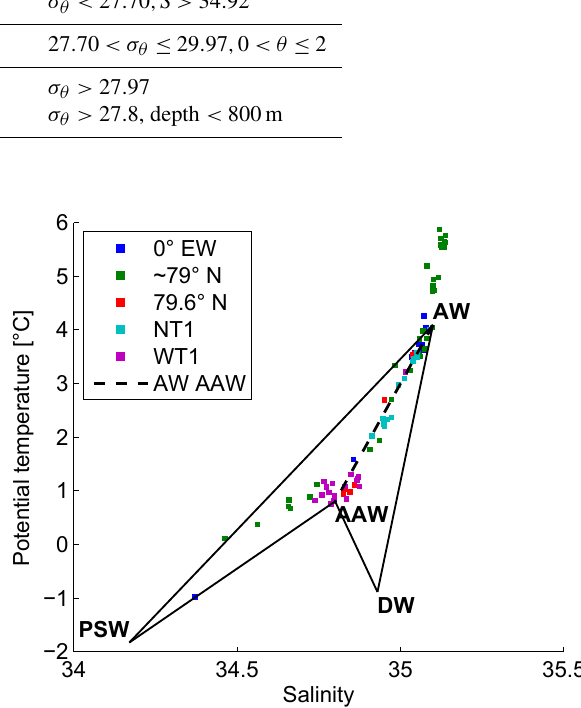
Figure 2. Mixing triangles of AW-AAW-PSW and AW-AAW-DW, abbreviations as in Table 1. Squares show the properties of the deep θ maximum at each